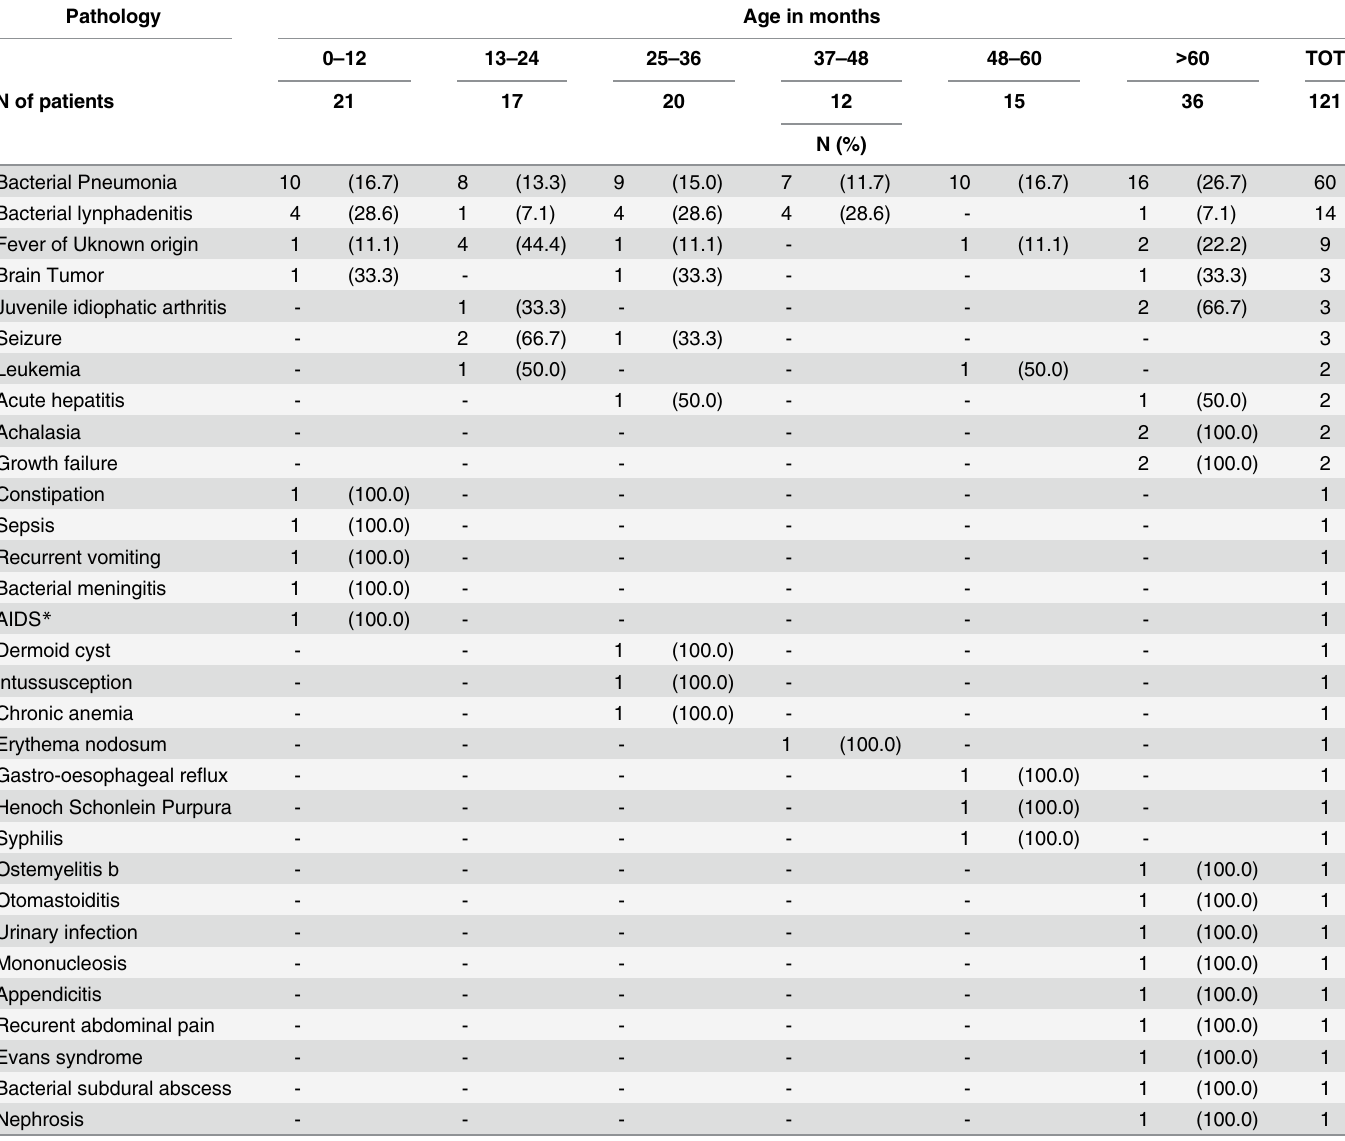
Table 4. Clinical characteristics of the 121 patients enrolled for active TB but with an alternative diagnosis (dotTB).